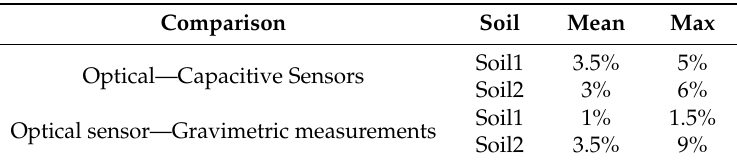
Table 1. Summary of measured errors between sensors.